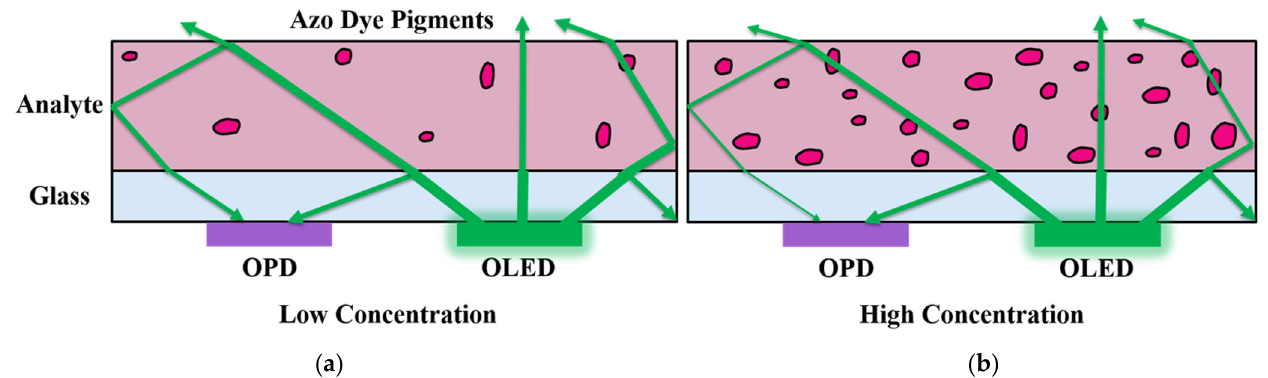
Figure 6. Schematic of the azo dye concentration-dependent absorbance of OLED light inside the analyte. ( a ) The light propagated partly inside the glass substrate and was partly reflected back onto the OPD; ( b ) for higher concentrations of nitrite standard sample and consequently higher concentrations of the azo dye the light showed increased absorption inside the chamber at the azo dye pigments. Thus, only a fraction of initial amount of light was reflected back onto the OPD. The photocurrent decreased as a consequence.